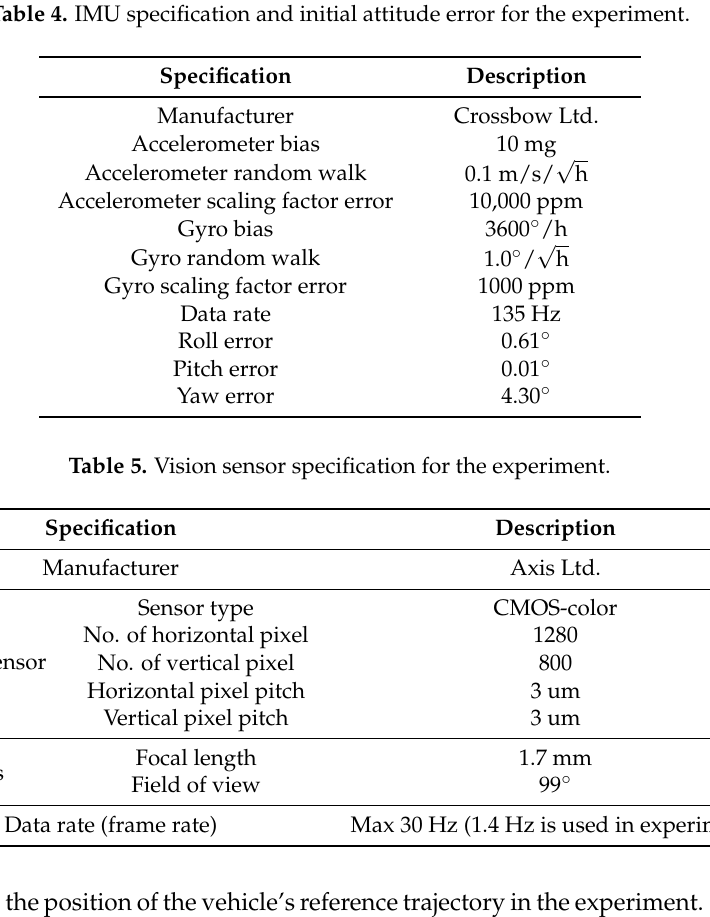
Table 4. IMU specification and initial attitude error for the experiment.